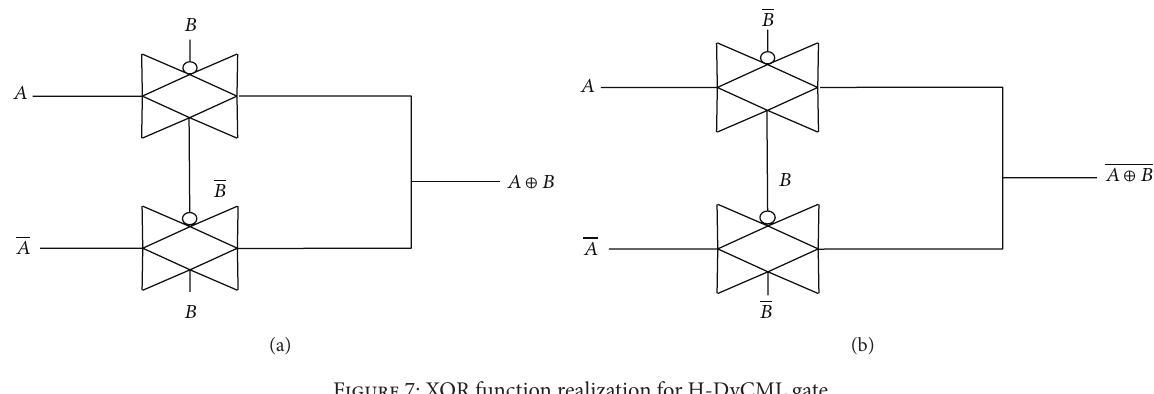
Figure 7: XOR function realization for H-DyCML gate.